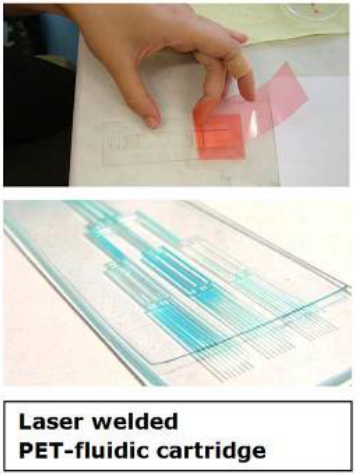
Figure 8. Laser-ablated fluidic